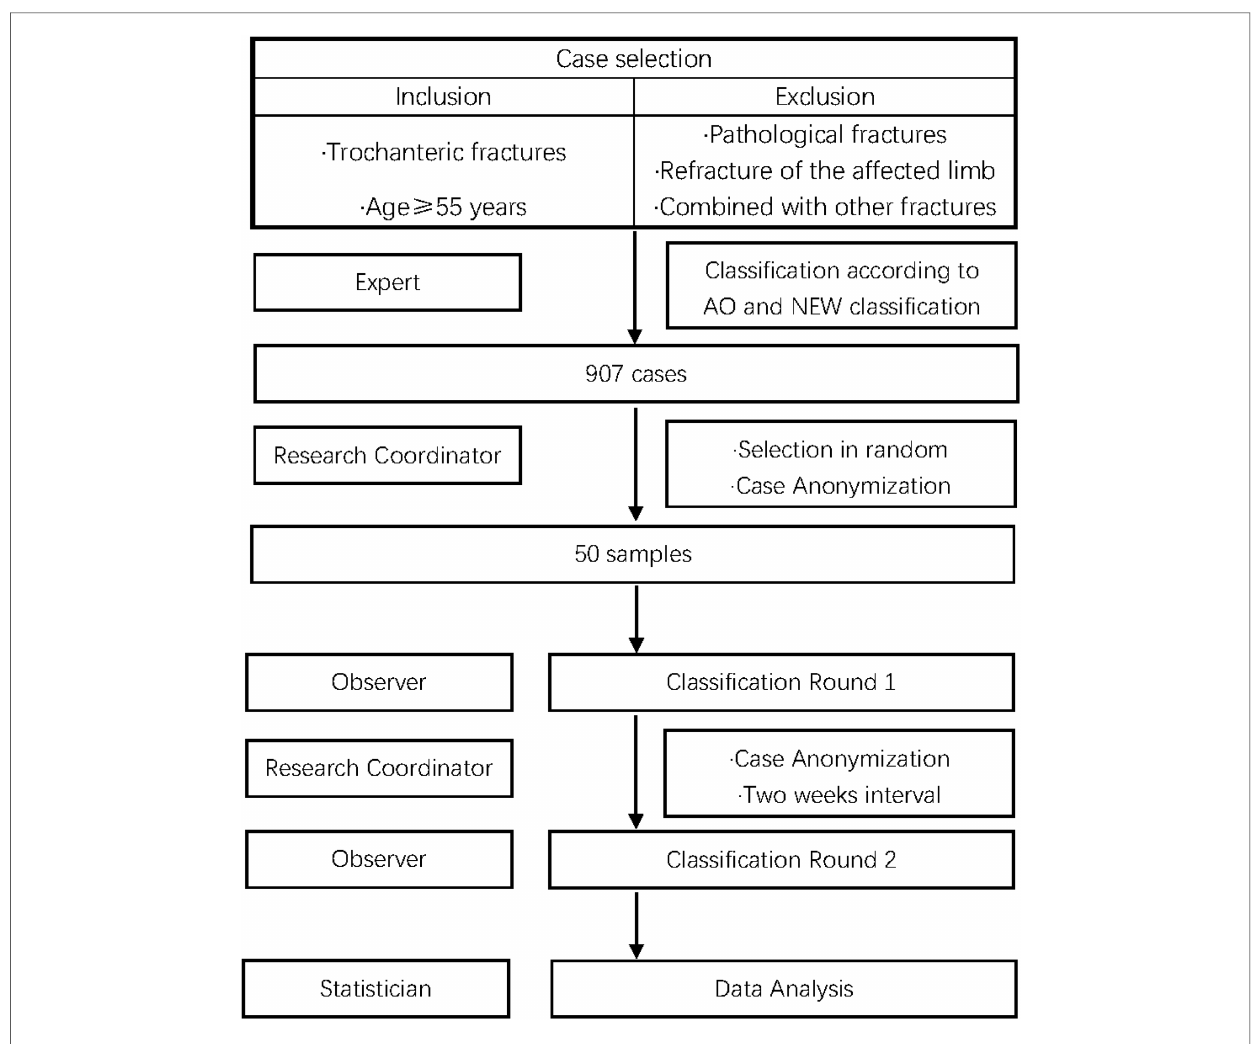
FIGURE 1 Study design. 50 anteroposterior radiographs of the classi fi ed cases were selected in random according to the proportion of AO classi fi cation and included: A1.1 (0.77%), A1.2 (25.69%), A1.3 (37.16%), A2.2 (18.96%), A2.3 (1.76%), A3.1 (0.99%), A3.2 (1.21%), A3.3 (9.70%), and AO unclassi fi able (3.75%). These selected cases were anonymized by the research coordinator and then classi fi ed by 5 orthopedic surgery residents (inexperienced group) and 5 orthopedic traumatologists (experienced group). The observers classi fi ed each case individually using the preoperative radiographs only. After a 2- week interval, the same cases were pre-sented in random sequence for repeat evaluation by 1 experienced and 1 inexperienced observer.